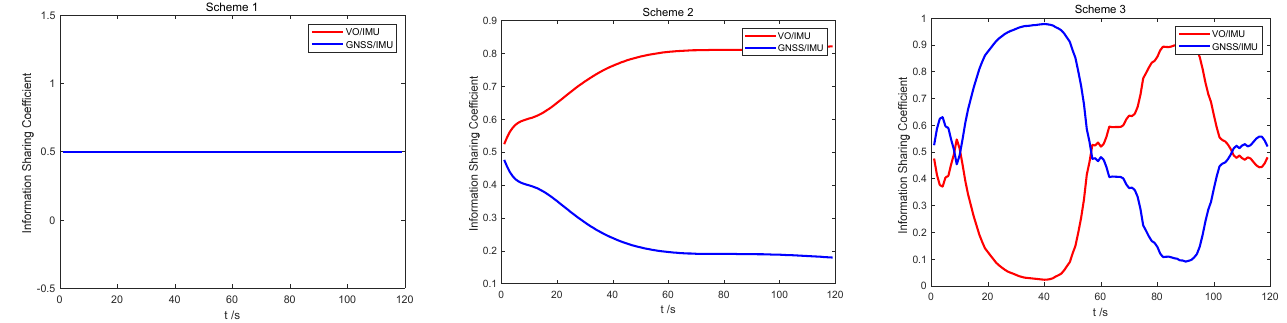
Figure 12. Information sharing coefficient of different schemes (Scheme 1, Scheme 2, Scheme 3).